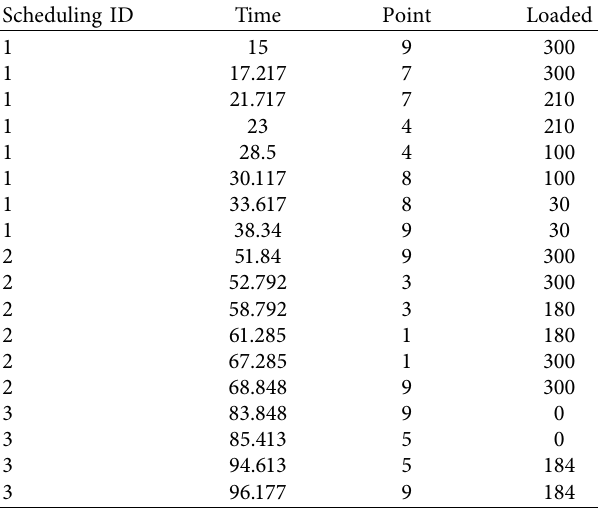
Table 5: Records of vehicle in the optimal scheduling scheme. Scheduling ID